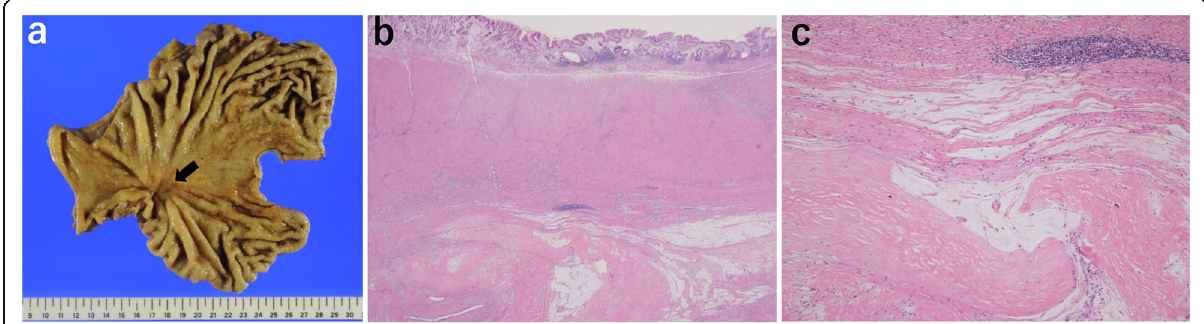
Fig. 5 Gross and pathological findings of the resected stomach. a Gross findings of the resected stomach. There is a 35 × 30-mm ulcerated lesion in the middle and distal stomach (arrow). b Low-power view of the lesion. Histologically, there is a scar with fibrosis and hyalinization from the mucosal layer to the serosa (hematoxylin and eosin stain, original magnification × 20). c High-power view of the lesion. Some mucin- containing areas are seen; however, there are no viable cancer cells remaining in the primary lesion (hematoxylin and eosin stain, original magnification ×